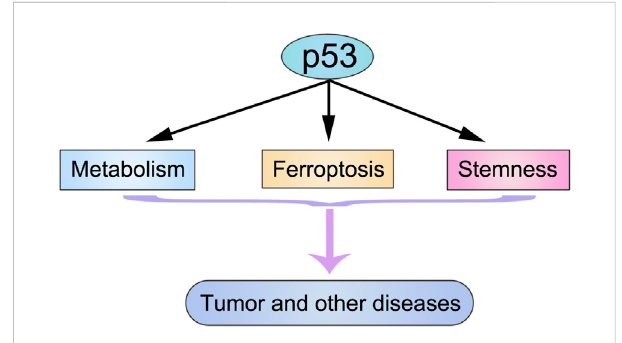
Modulating cell metabolism, ferroptosis, and stemness are three novel functions of